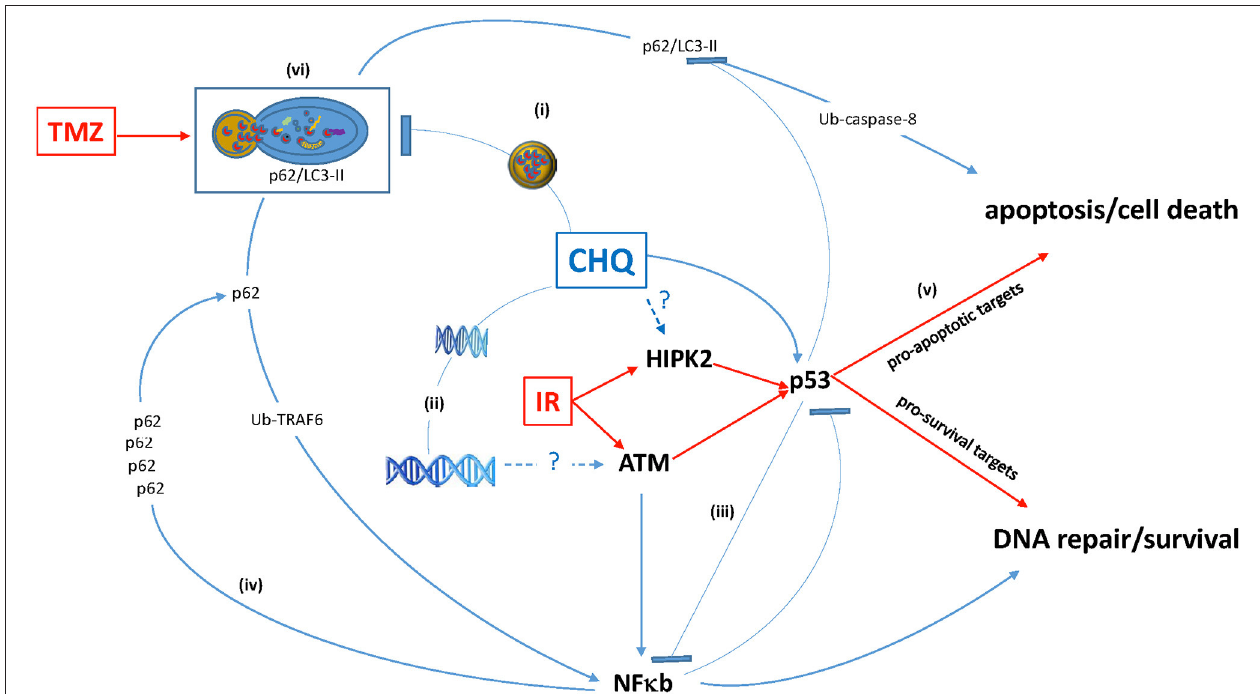
FIGURE 1 | Antagonistic pleiotropy of multifunctional hub proteins modulated by CHQ. (i) CHQ accumulation in the lysosome inhibits the lysosome-autophagosome fusion and impairs degradation of proteins including the ubiquitin (Ub)-binding protein p62 and its binding partner pro-apoptotic LC3-II. (ii) CHQ intercalates into the DNA helix and cause relaxation of chromatin structure, which may be the mechanism of ClQ-mediated activation of a DNA damage-inducible kinase ATM. (iii) CHQ modulates activities of pleiotropic transcription factors p53 and NF- κ B and may influence cross-talk between these pathways. (iv) p62 functional duality and positive p62 / NF- κ B feedback loop. (v) Augmentation of pro-apoptotic activities of p53 may be a possible mechanism of CHQ-mediated radiosensitization. (vi) Autophagy inhibition by ClQ may counteract autophagic activation by TMZ and thereby sensitize glioma cells to chemotherapy.